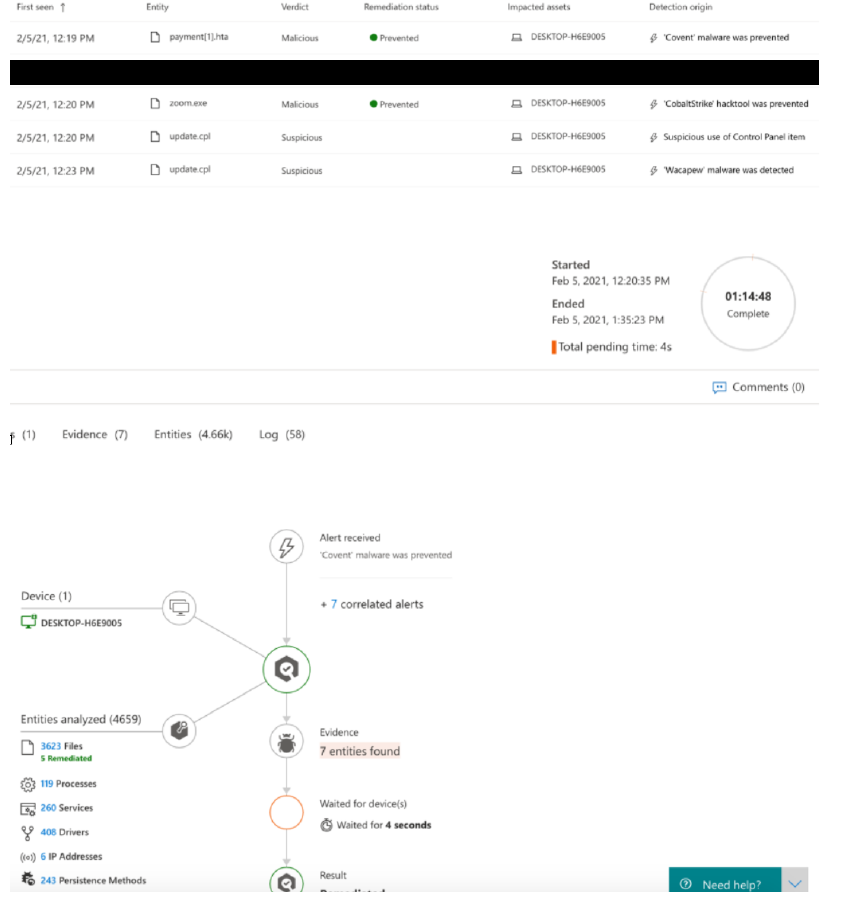
Figure 29. Auto investigation by